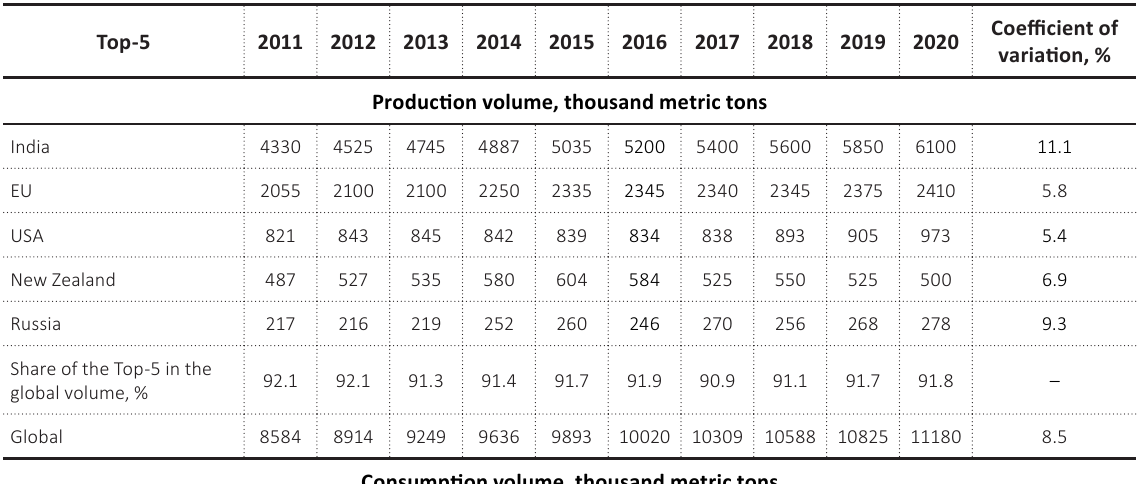
Source: U. S. Department of Agriculture